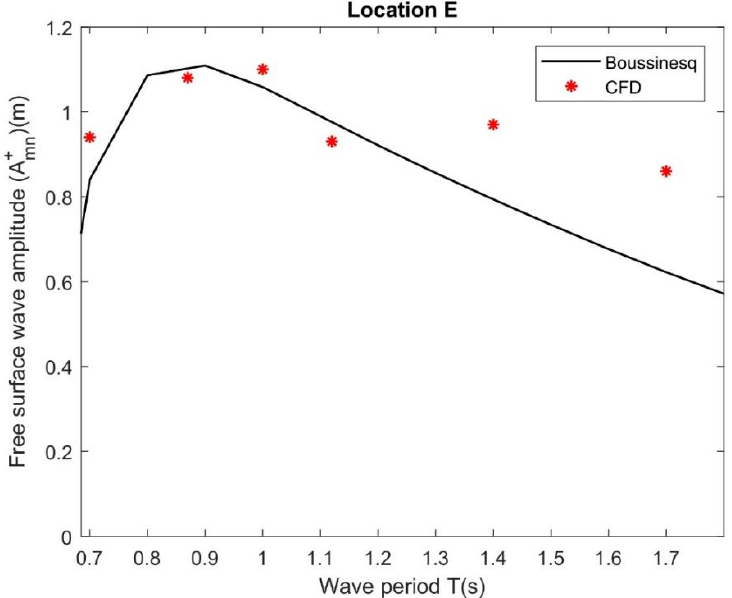
Figure 16. Comparison of Boussinesq, second-order super-harmonic wave amplitude A + mn in Equation (29) and CFD models of free surface elevation for location D.